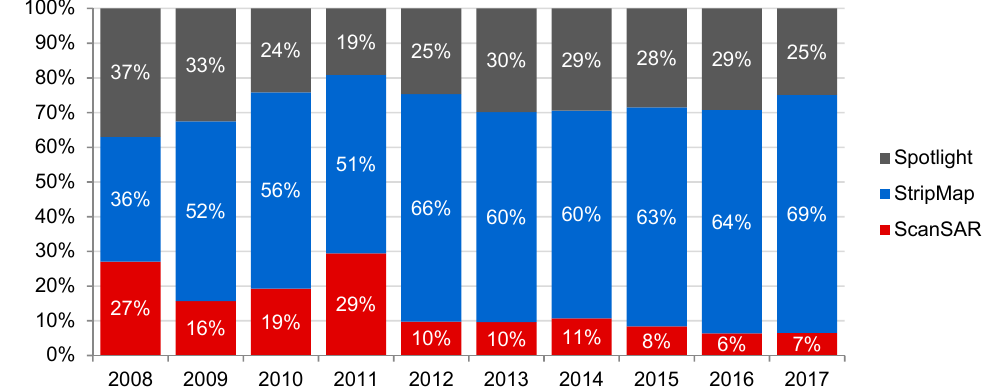
Figure 10. Proportion (in percent) of TerraSAR-X modes on an annual basis from 1 January 2008 to 30 June 2017: High-resolution Spotlight mode displayed on top, the medium resolution StripMap mode in the middle and the coarser resolution ScanSAR mode at the bottom.